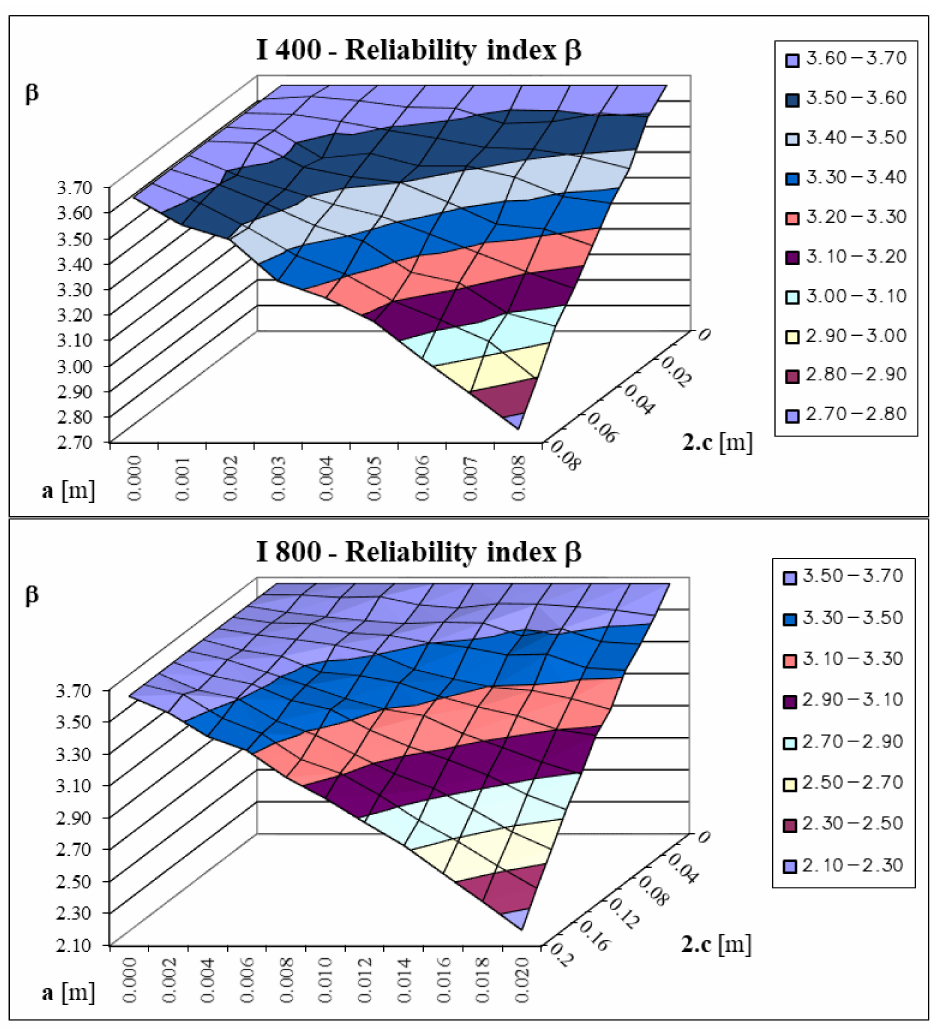
Figure 10. Influence of crack size on reliability index β